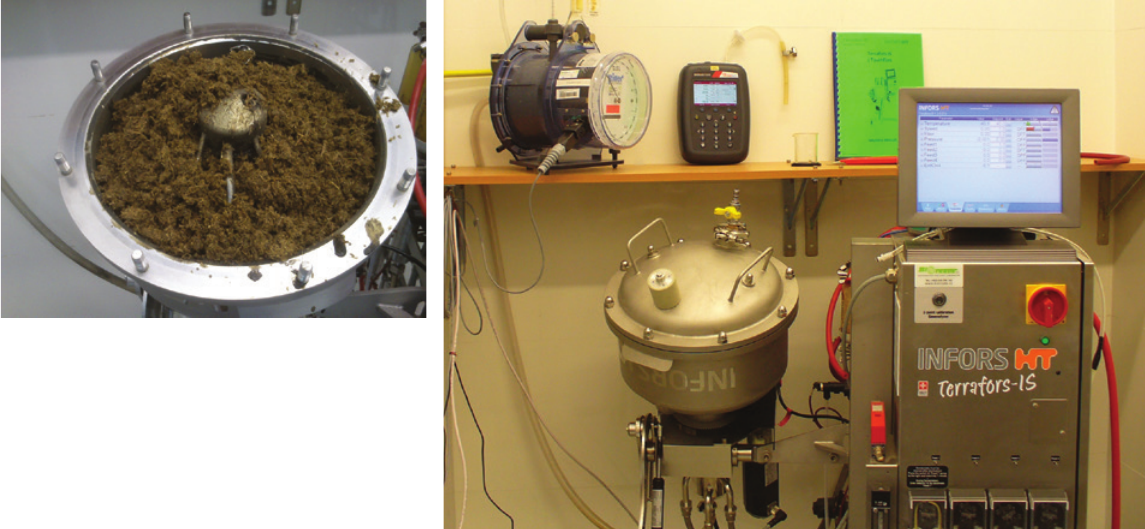
Figure 3: Rotary drum-type bioreactor Terrafors IS.